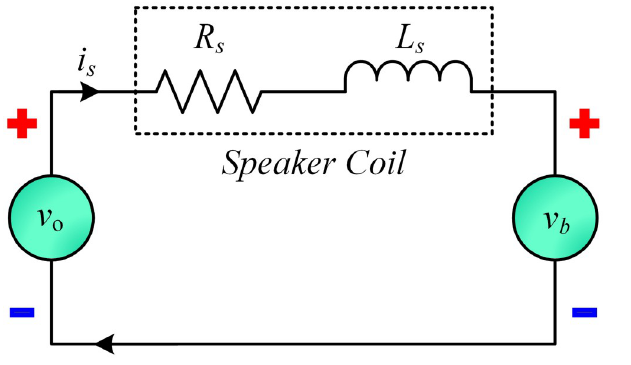
Fig 7. Electrical subsystem of speaker.